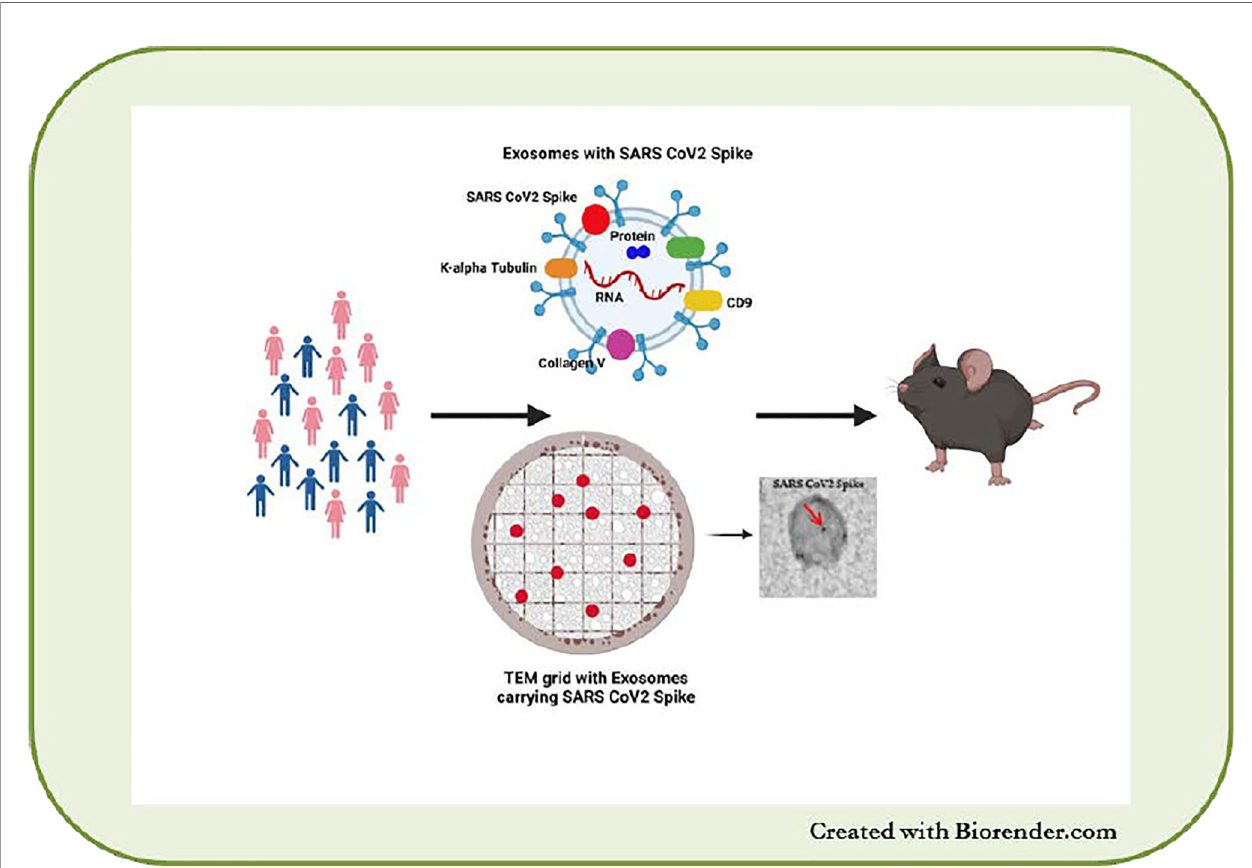
FIGURE 3 | sEVs from SARS-CoV-2 infected and vaccinated patients. Presence of SARS-CoV-2 spike protein on sEVs and immunization of mice with the sEVs leads to development of SARS-CoV-2 antibodies in